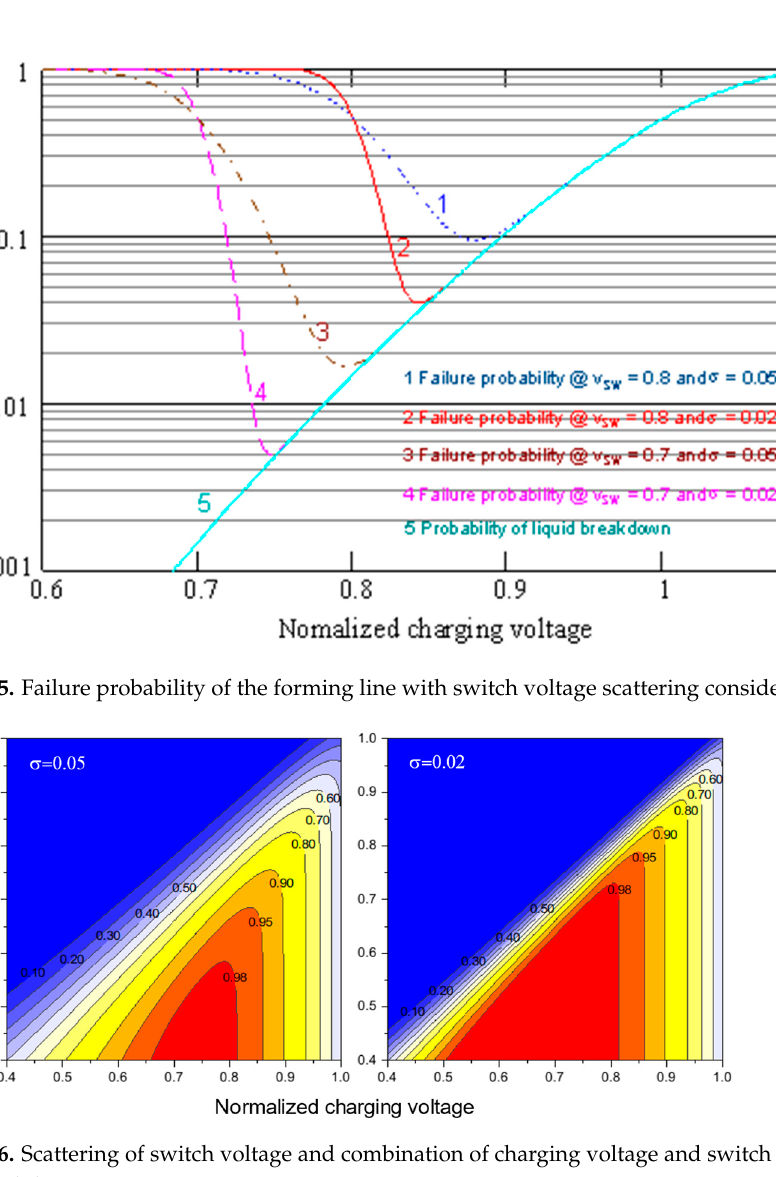
Figure 6. Scattering of switch voltage and combination of charging voltage and switch voltage affect PFL reliability.